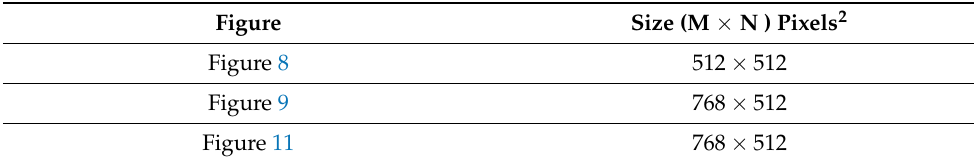
Table 3. Picture size in pixels. The color depth is 8 bits per